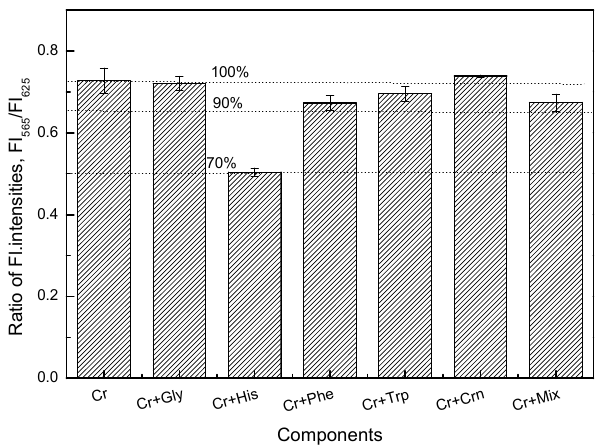
Figure 5. Response of the creatine-sensing membrane to aqueous solutions of 1.0 mM creatine (Cr) and 0.2 mM of each of the following components: Gly; glycine, His; histidine, Phe; phenylalanine, Trp; tryptophan, Crn; creatinine, Mix: mixture of Gly, His, Phe, Trp, and Crn. Table 1. Summary of the analytical performance of some creatine biosensors. Detection Method (Enzymes Used)